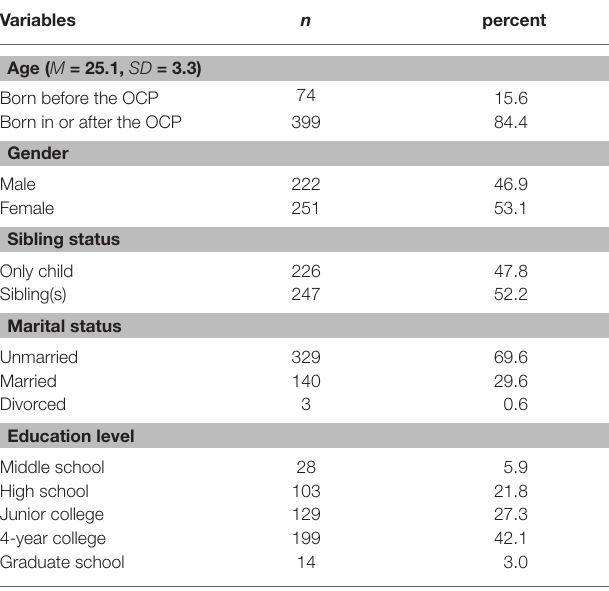
TABLE 1 | Characteristics of the sample ( n =